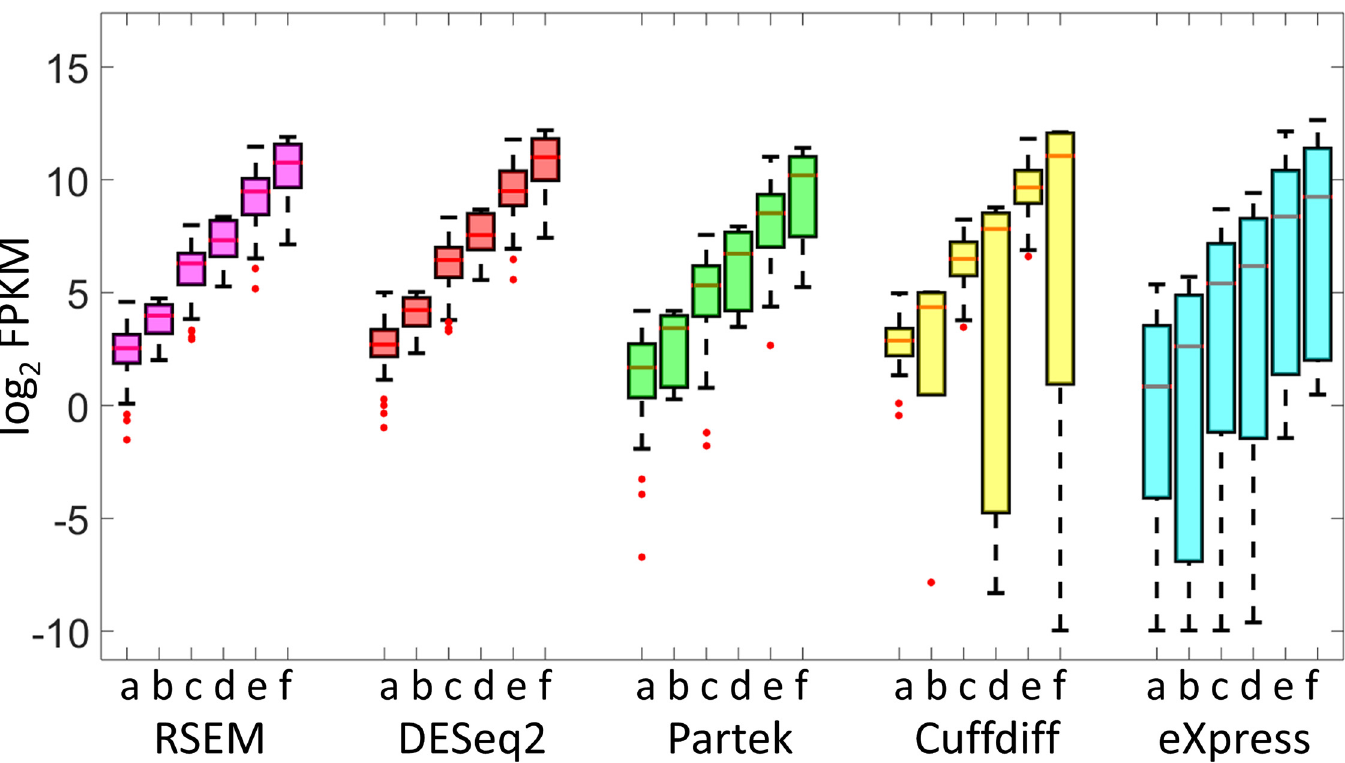
Fig 4. Abundance estimation of single locus transcript spike-ins using various bioinformatics tools. Spike-ins were quantified using various tools: RSEM, Partek, DESeq2, Cuffdiff and eXpress. Depicted are box plots of the observed versus the expected values for 19 spike-ins. In the X-axis (a-f) depicts spike-ins at a concentration of 50, 100, 500, 1000, 5000 and 10000 attomoles/ μ l respectively. The boxplots for the concentrations 50, 500 and 5000 attomoles/ μ l are based on 64 observations, the other three box plots are based on 12 observations.